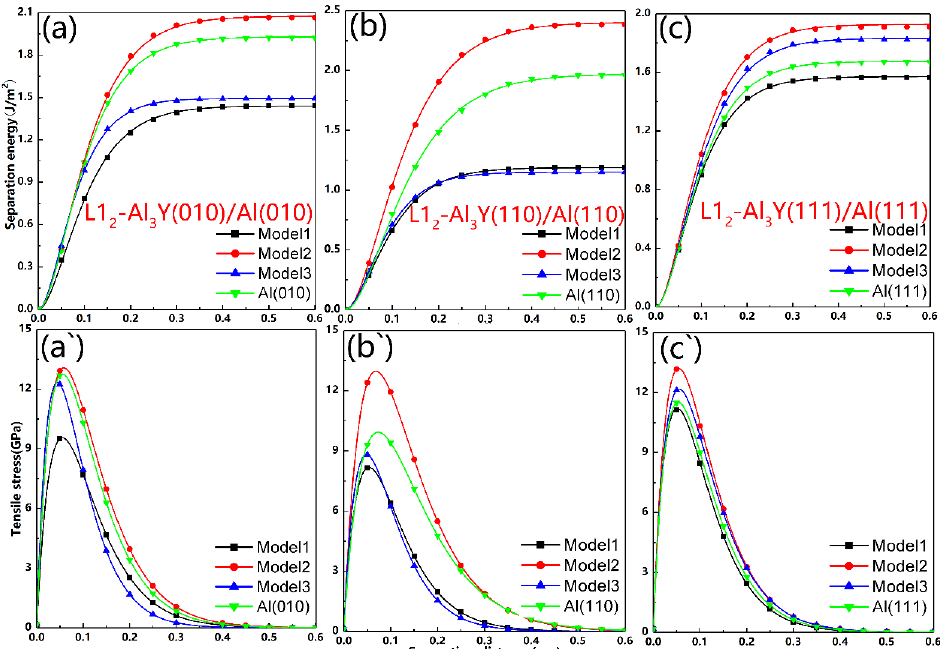
Figure 3. Theoretical tensile stresses ( σ max ) and separation energies for the interfaces modeled using the rigid method: ( a – c ) separation energy, ( a` – c` ) tensile stress. For the Al 3 Y(110)/Al(110), Al 3 Y(010)/Al(010), and Al 3 Y(111)/Al(111) interfaces, the σ max were calculated to be equal to 12.97, 13.28 and 13.39 GPa, respectively. The interface with the second stacking style (Model2) yielded the highest adhesion value ( W ad ) as well as theoretical tensile stress, which reflects good wettability and strength. Additionally, the atoms in this model were arranged similarly to the Al 3 Y or bulk Al. Thus, the interfacial structure determines the interfacial strength of the same low-index interface.